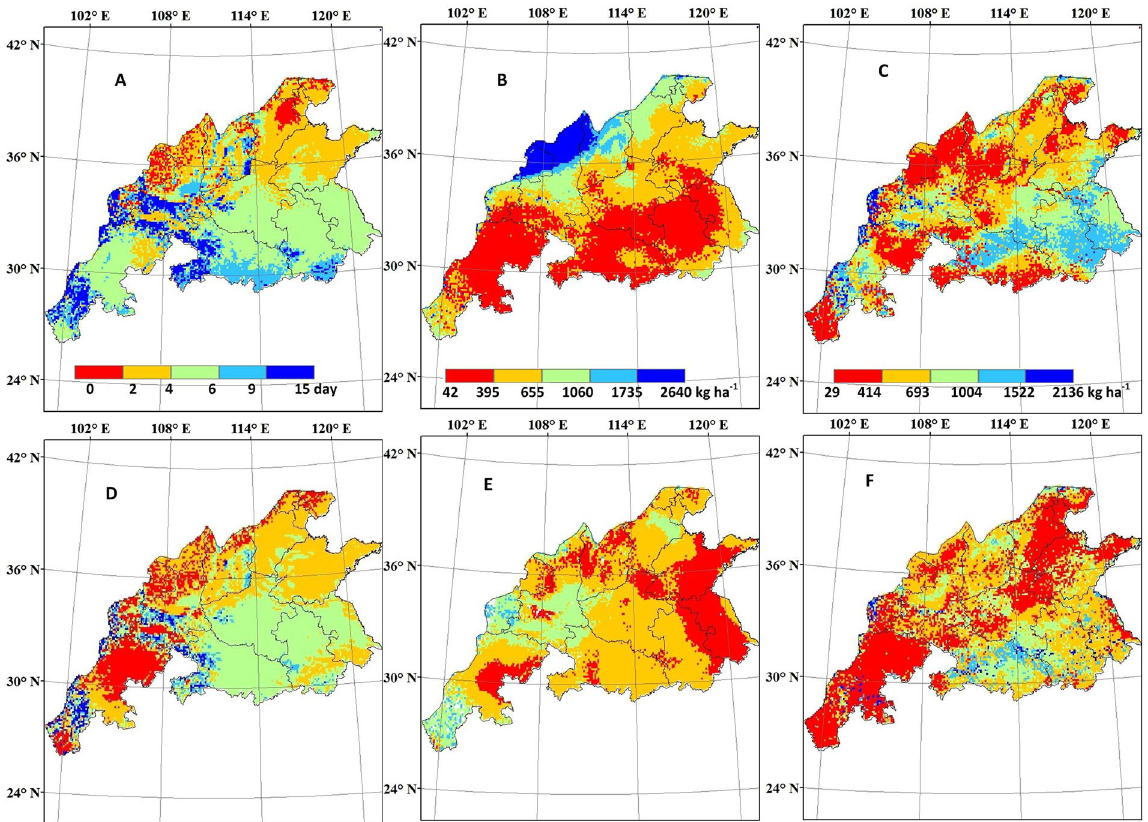
Figure 14. Spatial patterns of RMSD for maturity date ( A , D ), potential yield ( B , E ) and rainfed yield ( C , F ) of winter wheat, ( A – C ) CERES-Wheat; ( D – F ) WheatGrow (This figure was created by ArcGIS 9.3, http://www.